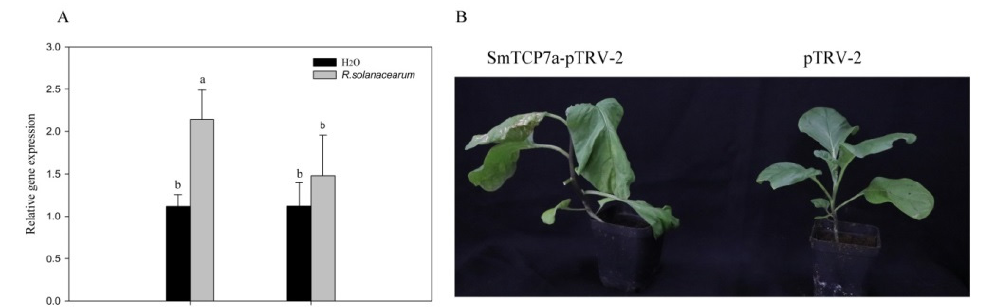
Figure 4. SmTCP7a positively regulates eggplant bacterial wilt resistance. ( A ) Analysis of the expression level of the SmTCP7a after inoculation with R. solanacearum at 48 hpi. Different letters indicate statistically significant difference (ANOVA, Duncan post hoc test, n = 3, α = 0.05). The data were analyzed by the SPSS17 software. ( B ) Eggplant wilted after VIGS of SmTCP7a. The photos were taken 7 days after inoculation with R. solanacearum .